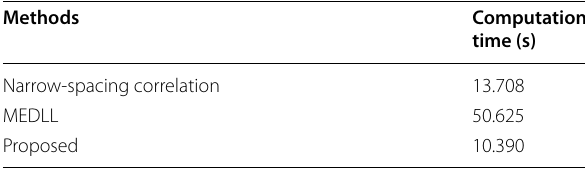
Table 4 Time spent processing 12 s satellite